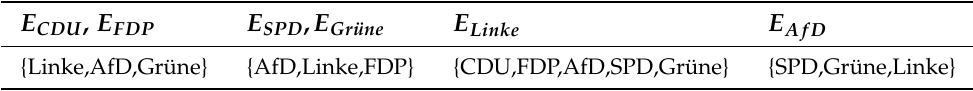
Table 5. Excluded coalition partners—German federal parliament.